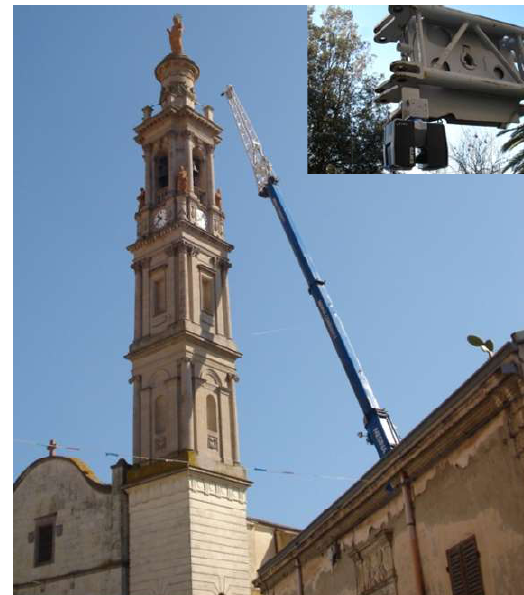
Figure 10: The Bell Tower